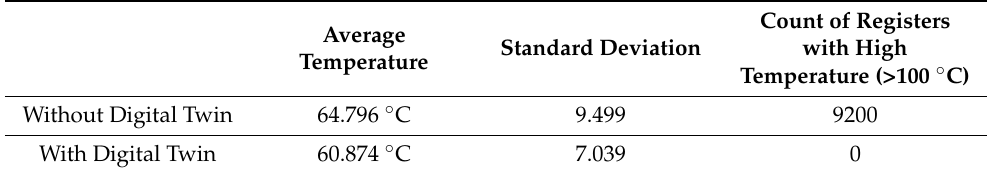
Table 3. Dispersion measurements that show how, when using the digital twin, the temperature of the return sand is reduced, it is also more constant and temperatures above 100 ◦ C are